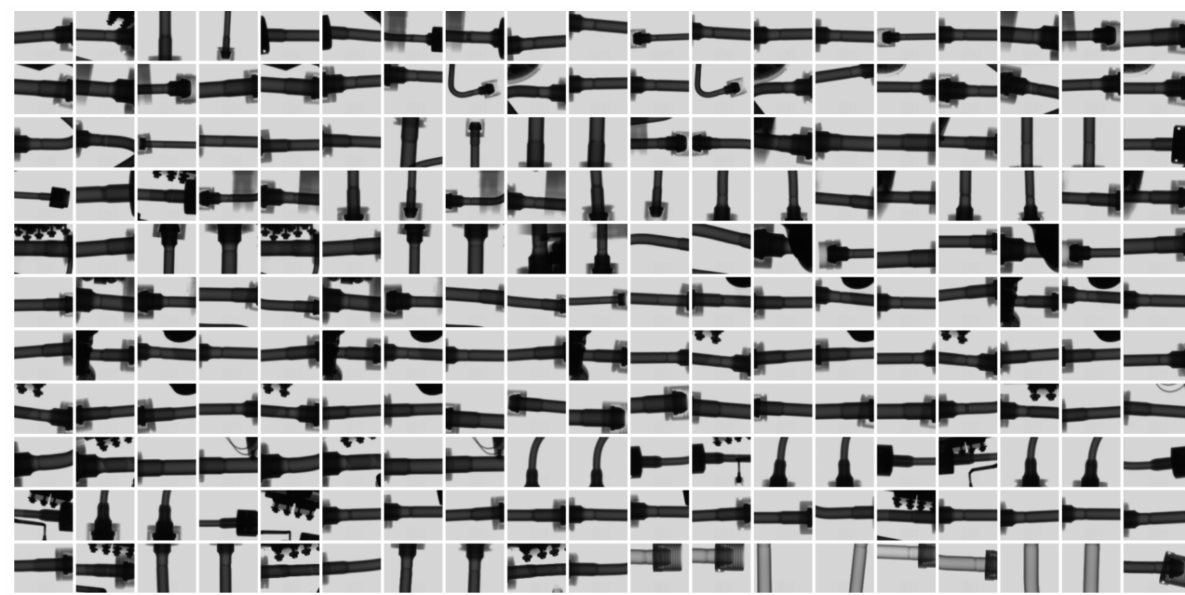
Figure 9. Some of the original images in the DSXImage dataset.